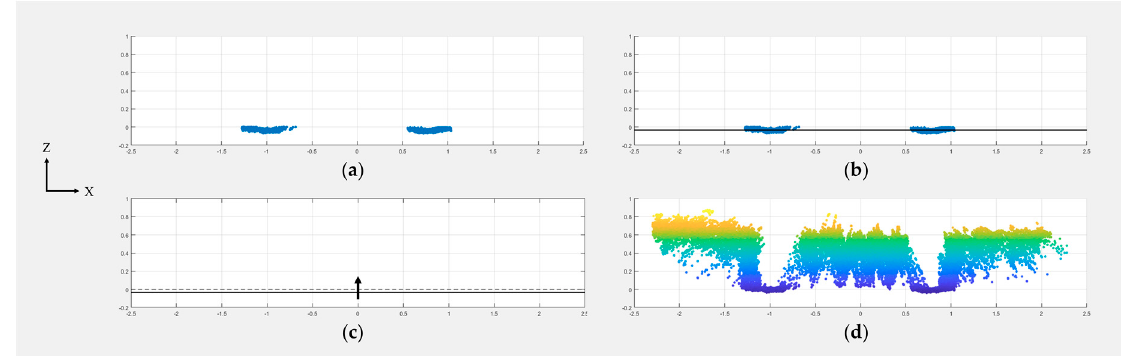
Figure A5. An example of ground baseline correction: ( a ) point cloud of ground before shifting; ( b ) the mean in the Z dimension; ( c ) points on the X-Z plane shifted by the offset; ( d ) point cloud after shifting.